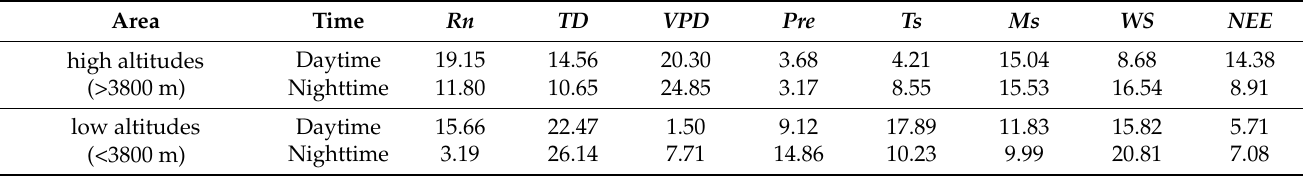
Table 2. The relative contribution (%) of each impact factor in daytime and nighttime at high and low